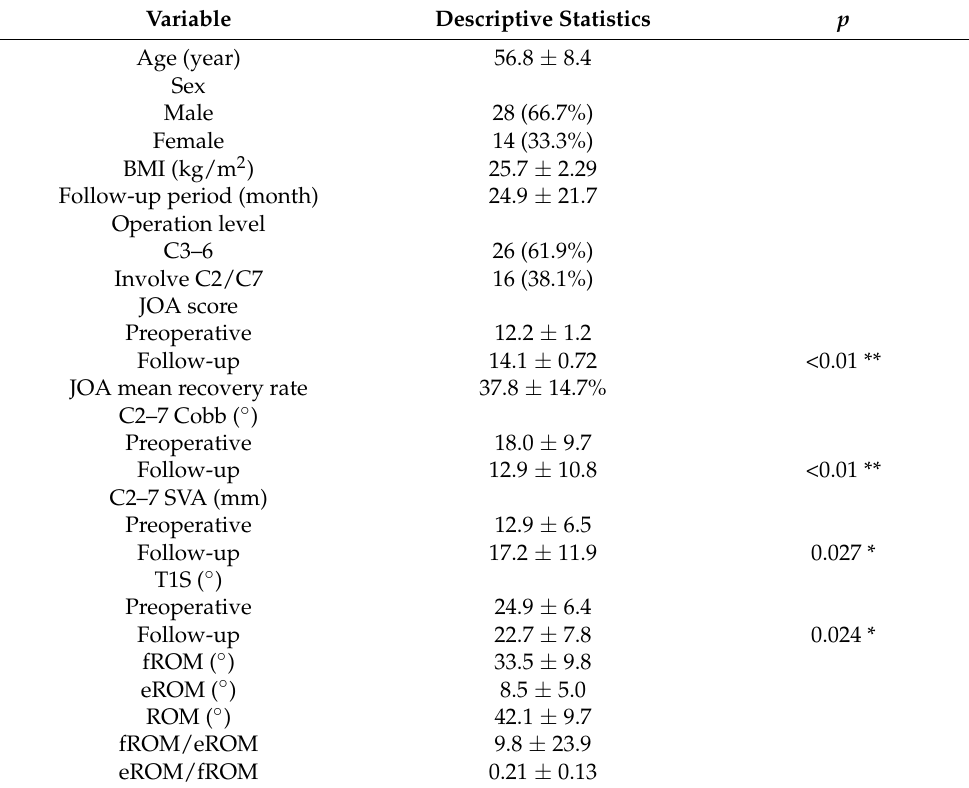
Table 1. Basal characteristics and clinical outcomes of the study